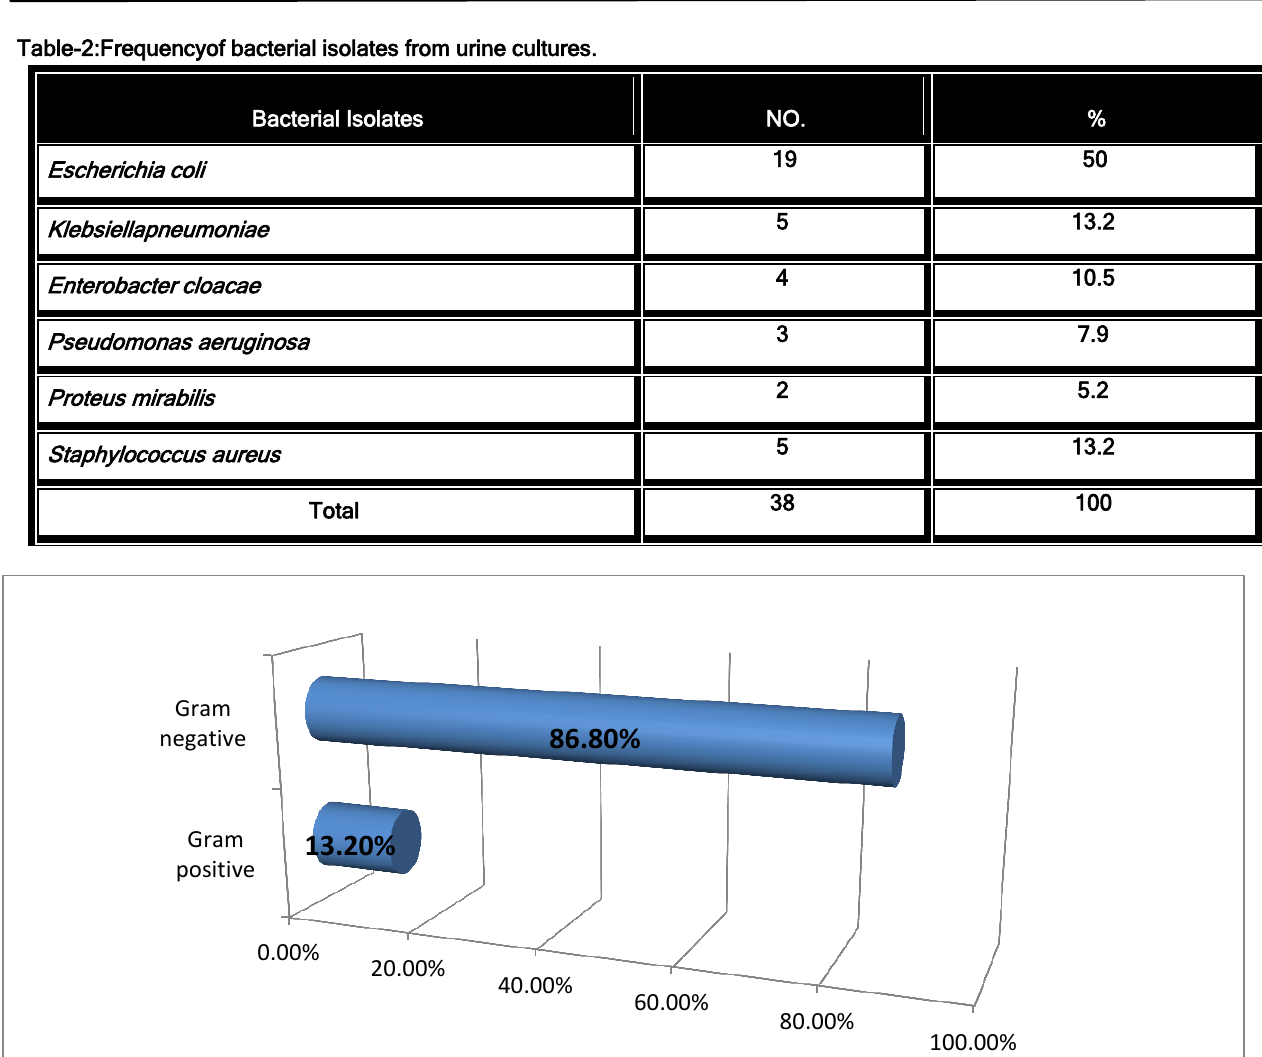
Figure -3: Frequencyof Gram positive and Gram negative bacteria isolated from urine cultures